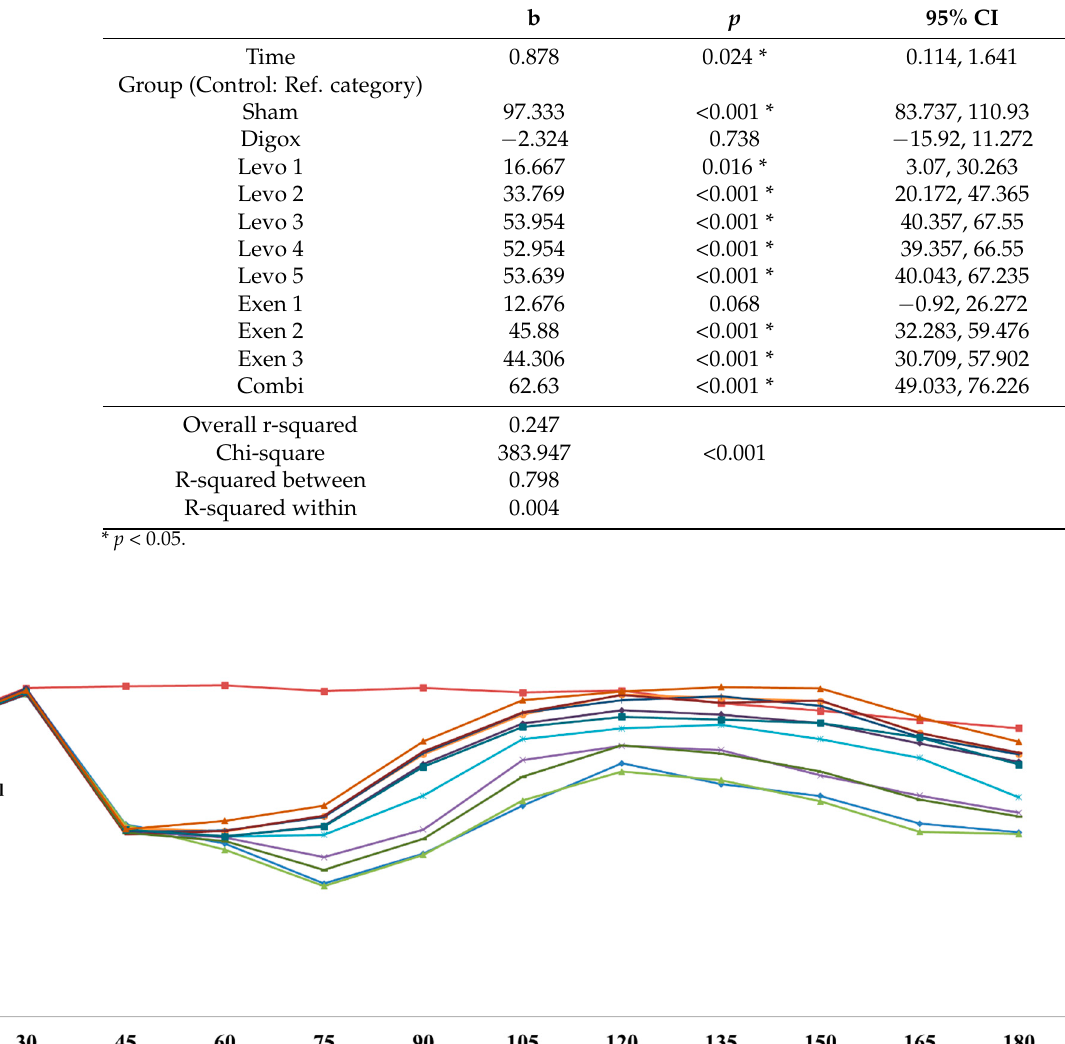
Table 4. Longitudinal analysis for HR for all groups.